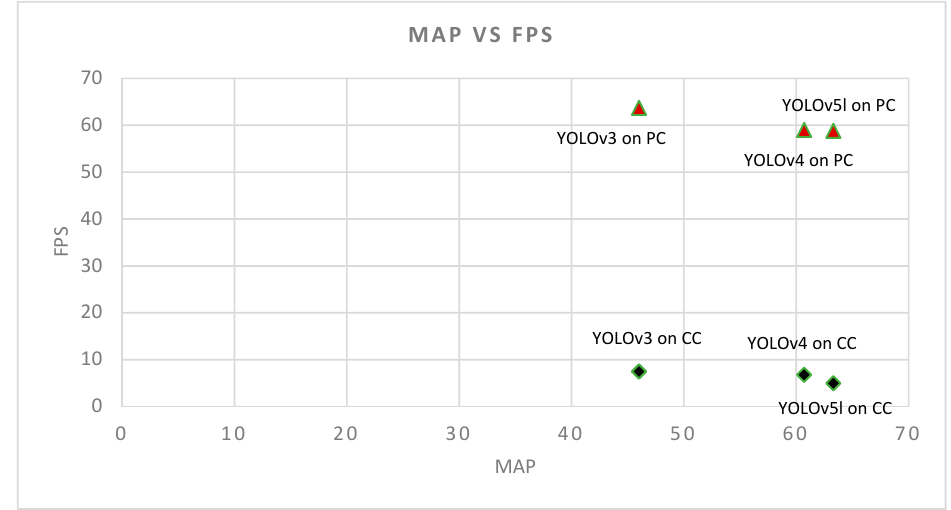
Figure 5. Performance of YOLOv3, YOLOv4, and YOLOv5l in PC ( ) and Companion Computer